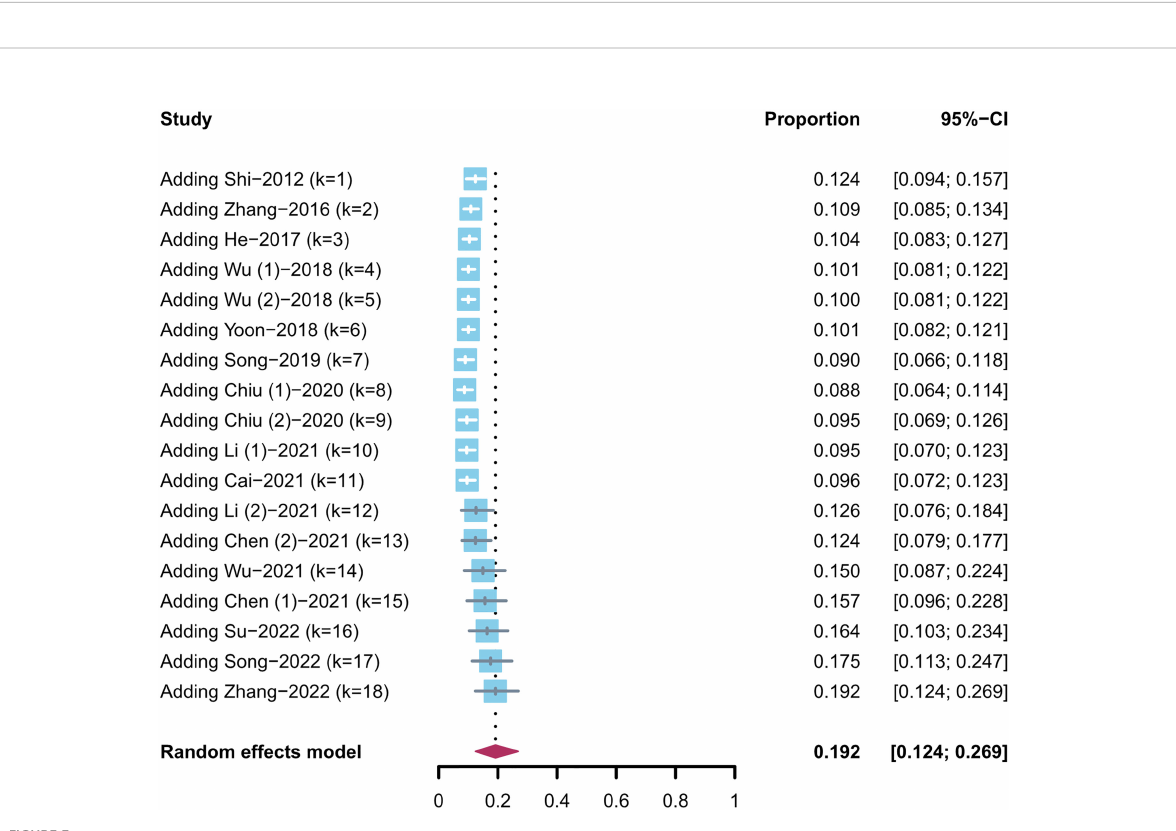
FIGURE 3 Cumulative meta-analysis of uHCC conversion rate (trend with time).